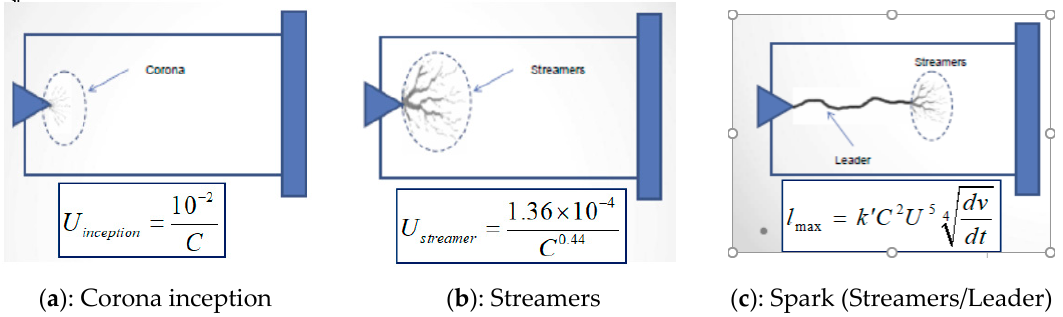
Figure 2. Steps of creeping discharges according to Reference [2].